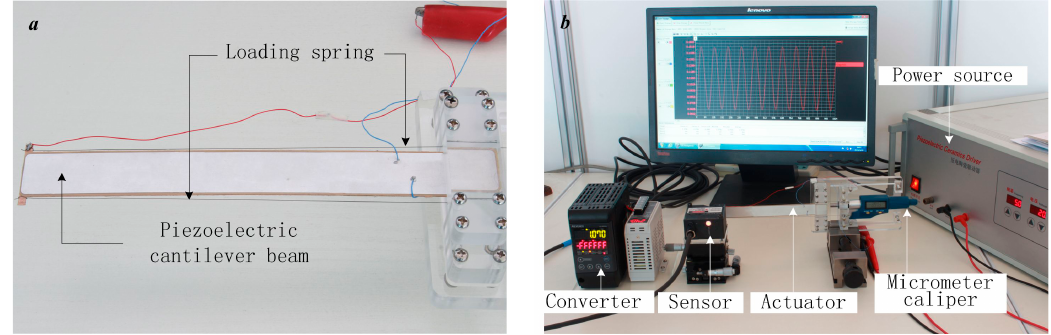
Figure 10. ( a ) The structure of the experimental pretension actuator; ( b ) the remaining necessary experimental